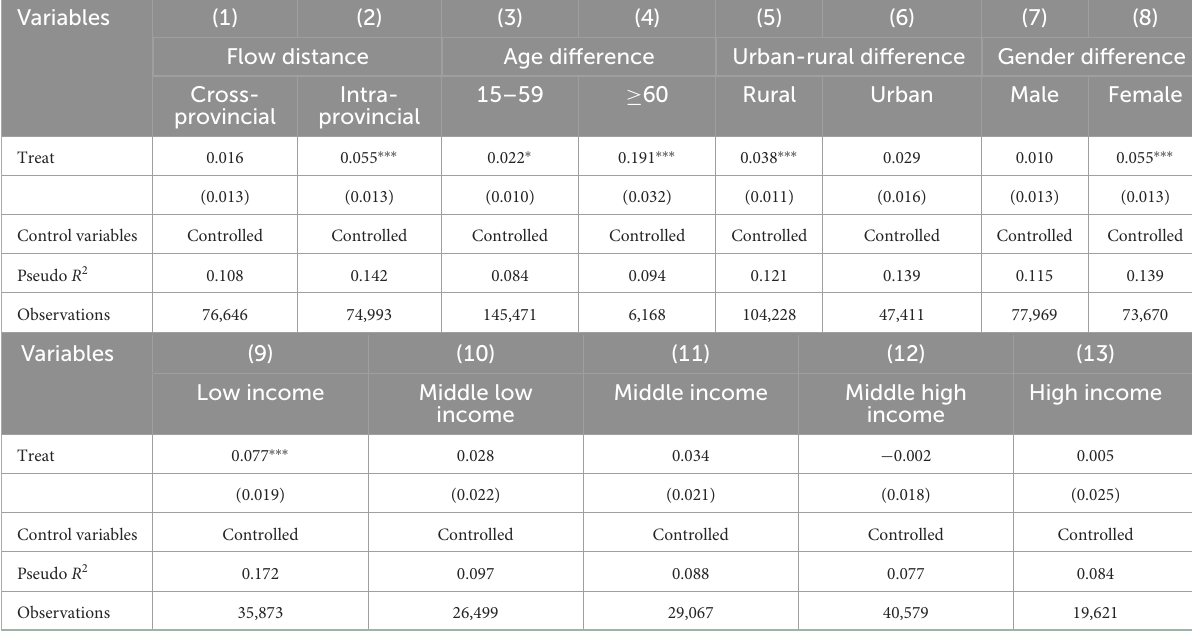
TABLE 4 The regression results of the heterogeneous analysis.